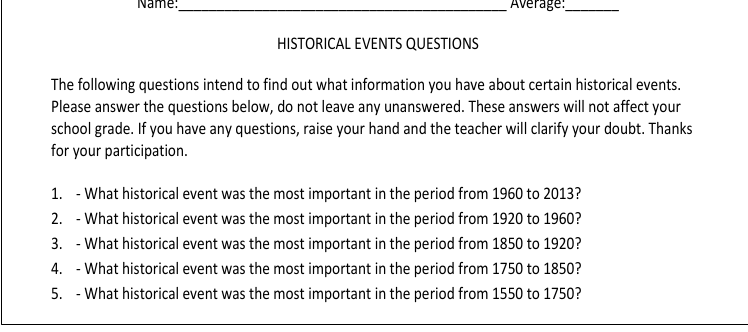
Figure 1 . Open-ended questionnaire to assess students’ historical